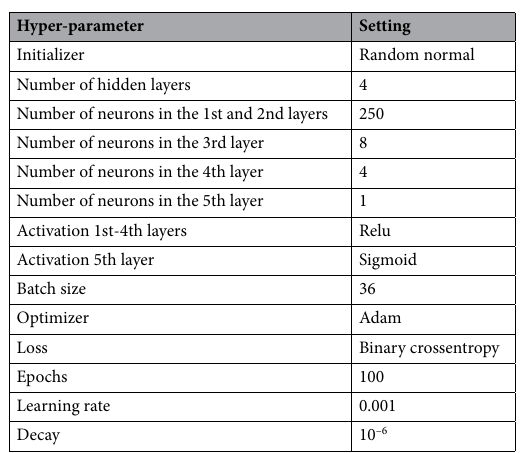
Table 2. Hyper-parameter settings of the best d MLP model.